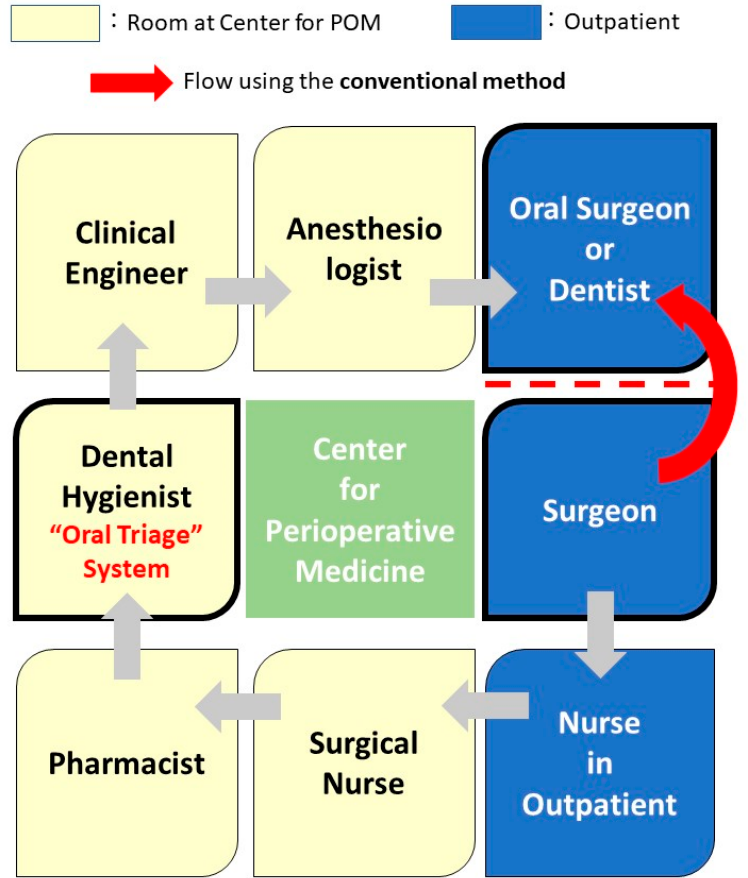
Figure 1. Patient flow at the Center for Perioperative Medicine and “oral triage”. In the “oral triage” system, the surgeon is the starting point. The patient is referred to various departments (as shown in a clockwise direction in this schematic figure), and finally, the oral management is performed by the oral surgeon. In the conventional method, as shown by the curved red arrow, the surgeons directly consult the oral surgery clinic.